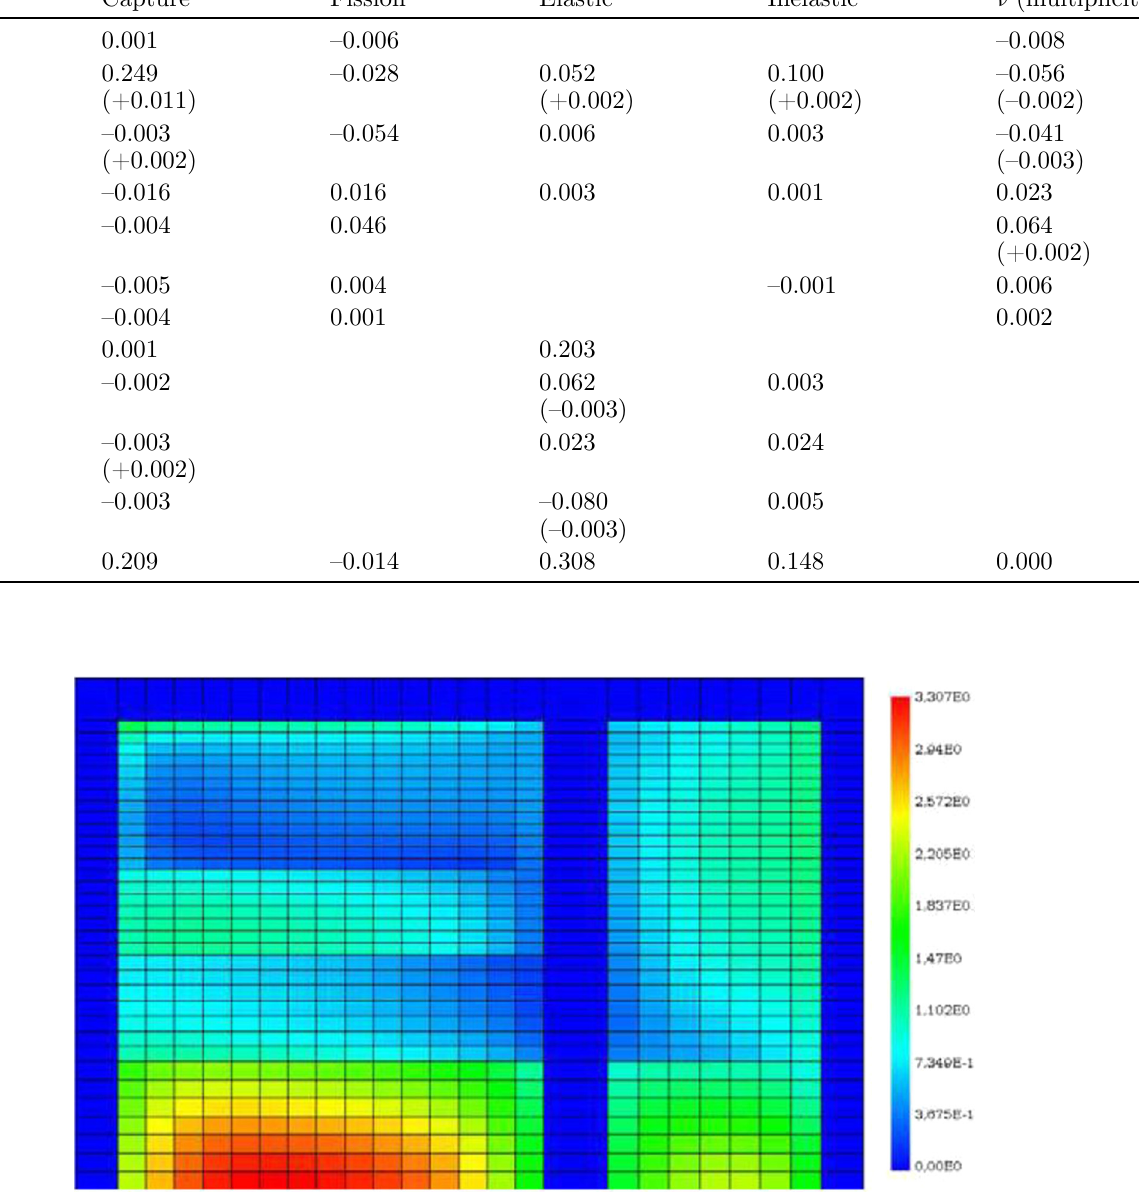
Fig. 2. Uncertainty map for the R i ratios over the 748 regions of discrete description P1